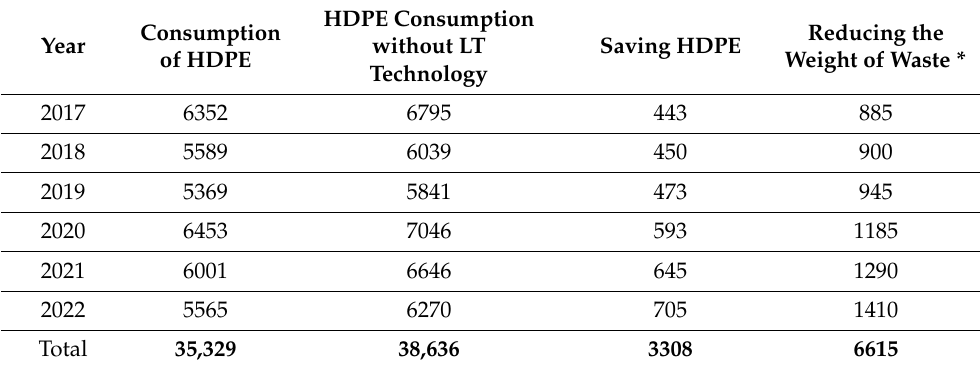
Table 8. Estimated HDPE consumption data in Poland for the production of agricultural mesh in the years 2017–2022 in